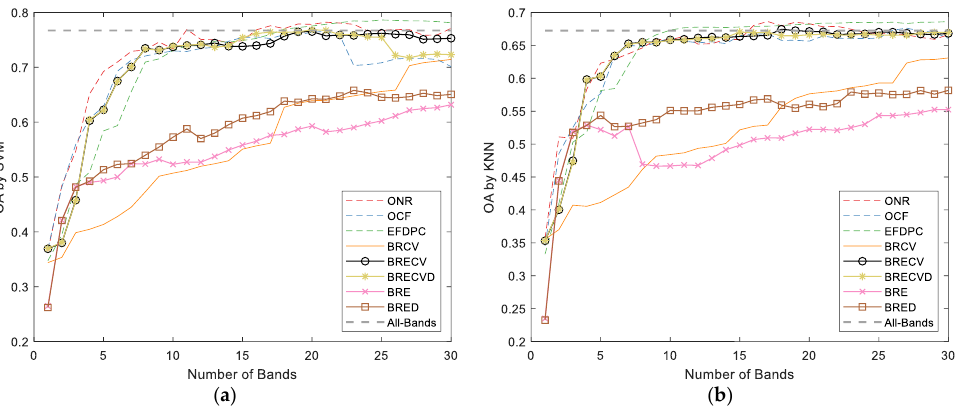
Figure 2. Overall accuracy (OA) curves produced by support vector machine (SVM) and k-nearest neighborhood (KNN) classifiers for the Indian Pines data set. ( a ) The OA curves produced by SVM classifier. ( b ) The OA curves produced by KNN classifier.